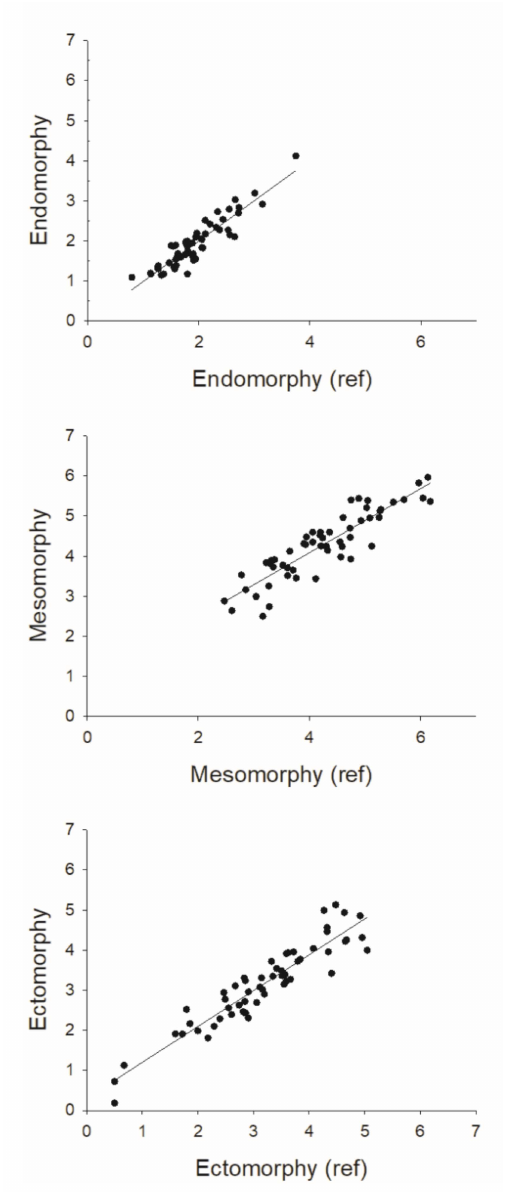
Figure 1. Scatterplot of the relationship between the somatotype components obtained by the reference method and the new